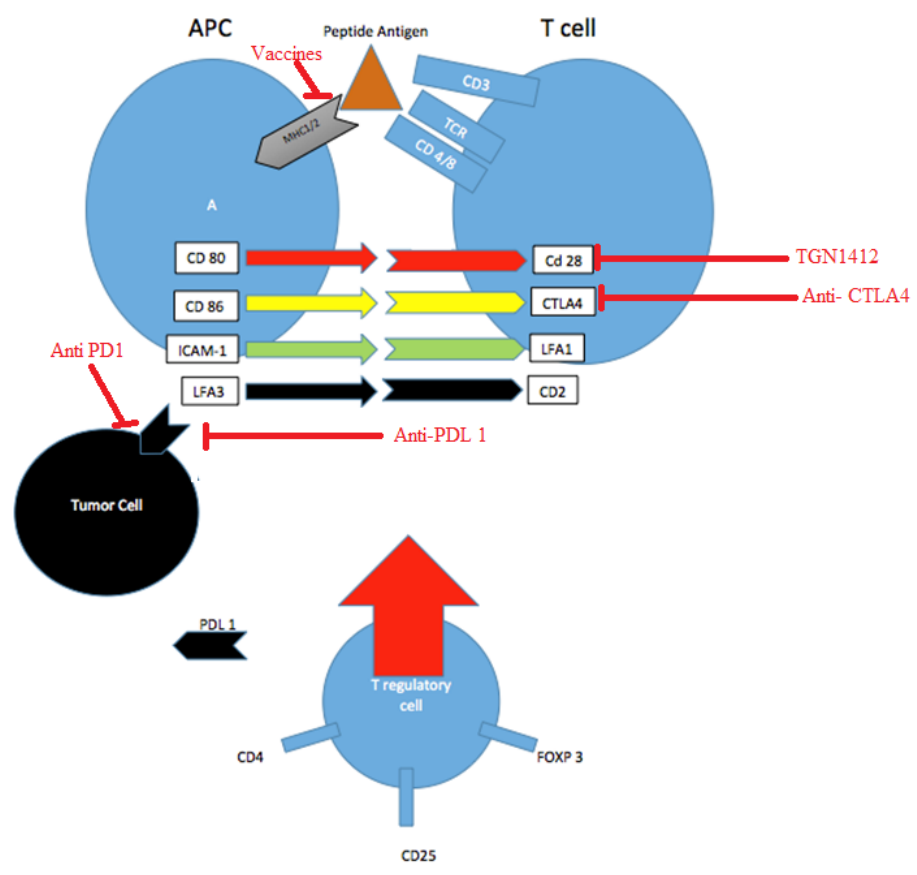
Figure 1. T cells recognize antigens presented to the T ‐ cell receptor (TCR) as antigen peptides within the major histocompatibility complex of the Antigen Presenting Cells (APC) and tumor cells.